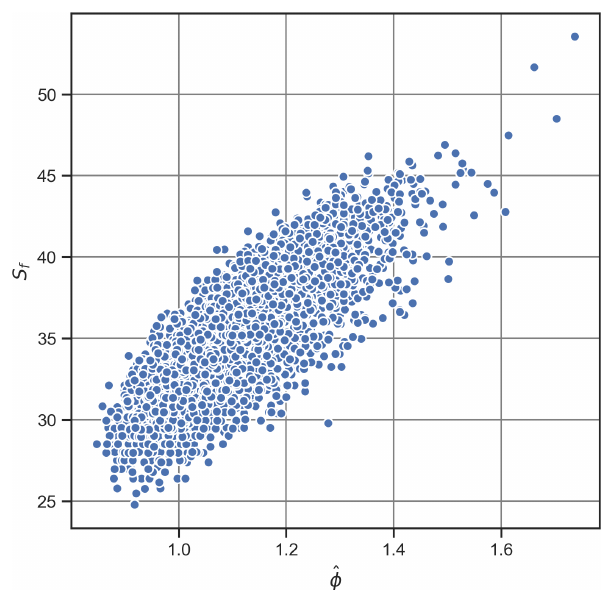
Figure 5. Scatterplot of the index of dispersion ˆ φ versus the S cl met- ric for all selected catchments for the initial parameter combination ( r = 2d, t = 99p, w =